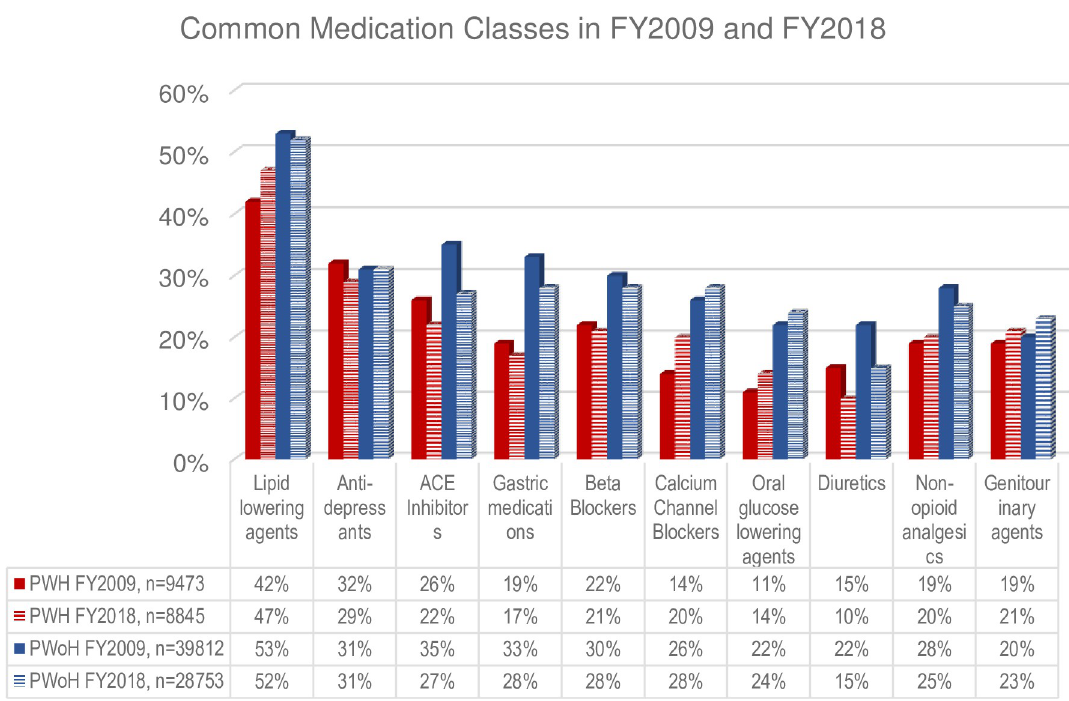
Fig 1. Top ten non-ARV medications in FY2009 and FY2018. https://doi.org/10.1371/journal.pone.0276769.g001 1.59), respectively; demonstrating a dose-response relationship (Table 3). In HIV stratified models, the dose-response relationship between medication count and MICU admission was observed, with a stronger association among PWH (Table 3). Among PWH, compared to � 4